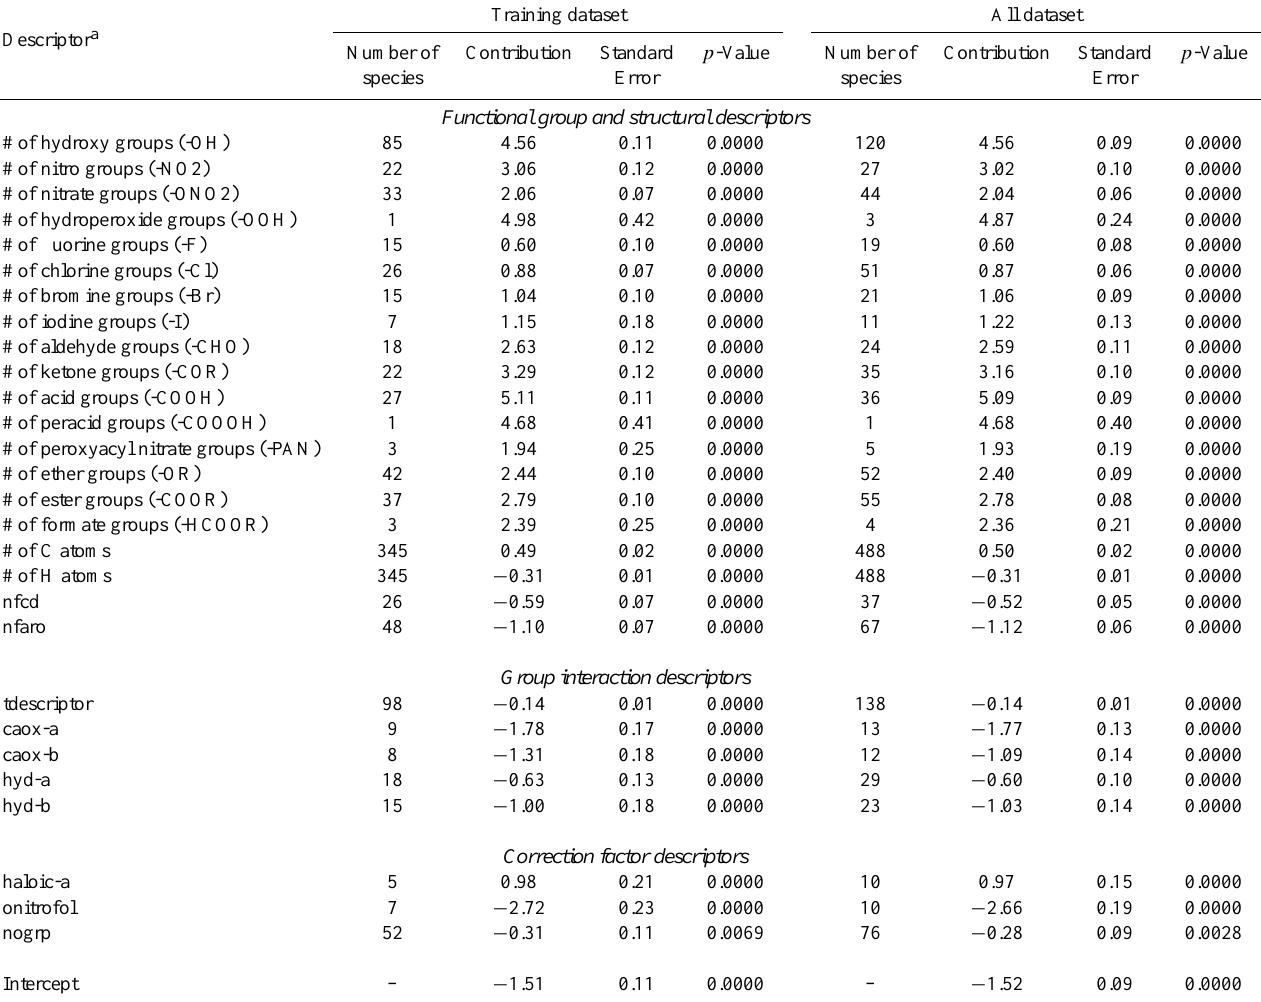
Table 1. Descriptors for the model GROMHE, number of species in the database contributing to the descriptor and their related contribution, standard error and statistical significance in the